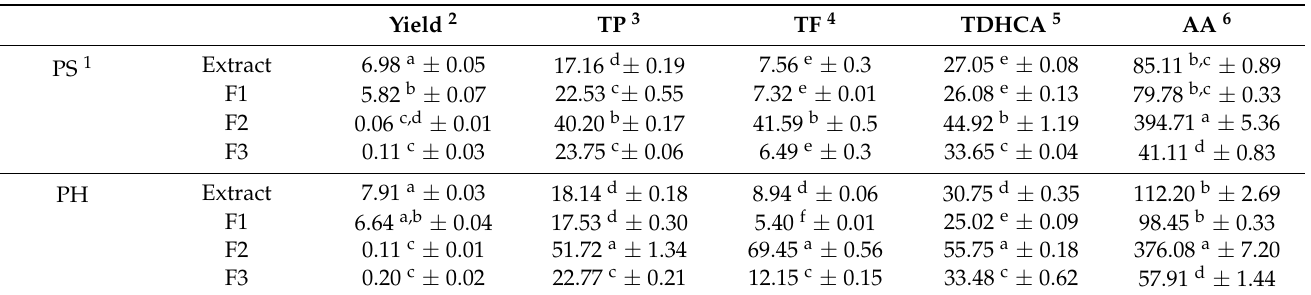
Table 1. Extraction yield, phenolic content, and antioxidant activity of ethanolic extract (E) and water (F1), methanol-water 40% (F2), and 70% (F3) fractions obtained from sweet (PS) and hot (PH) pepper